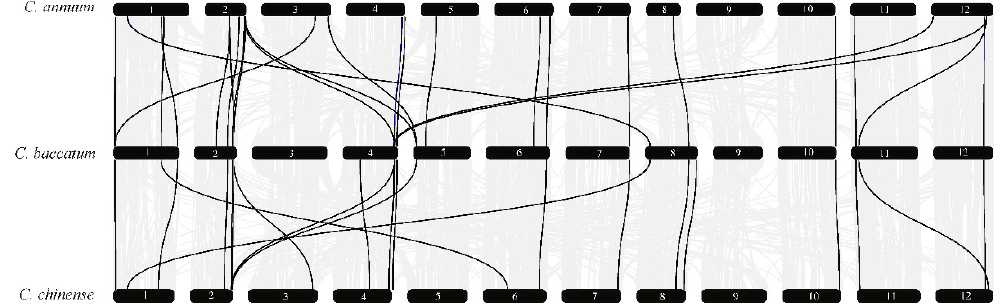
Figure 5. Collinearity of type II MADS-box genes in C. annuum, C. baccatum, and C. chinense.